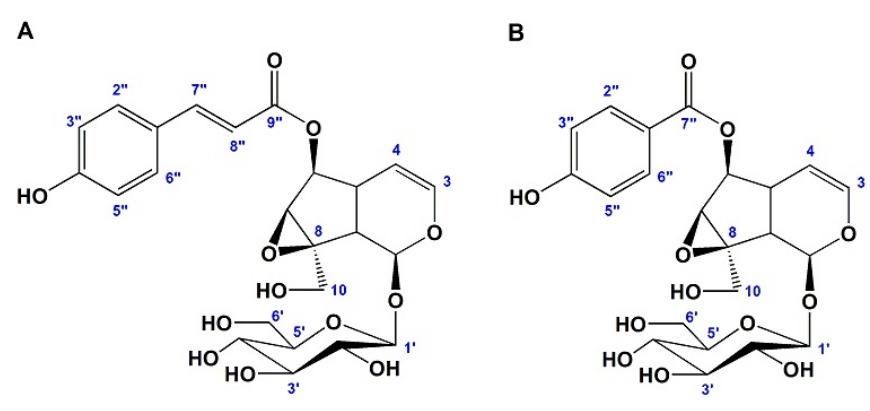
Figure 1. Chemical structure of specioside ( A ) and catalposide ( B